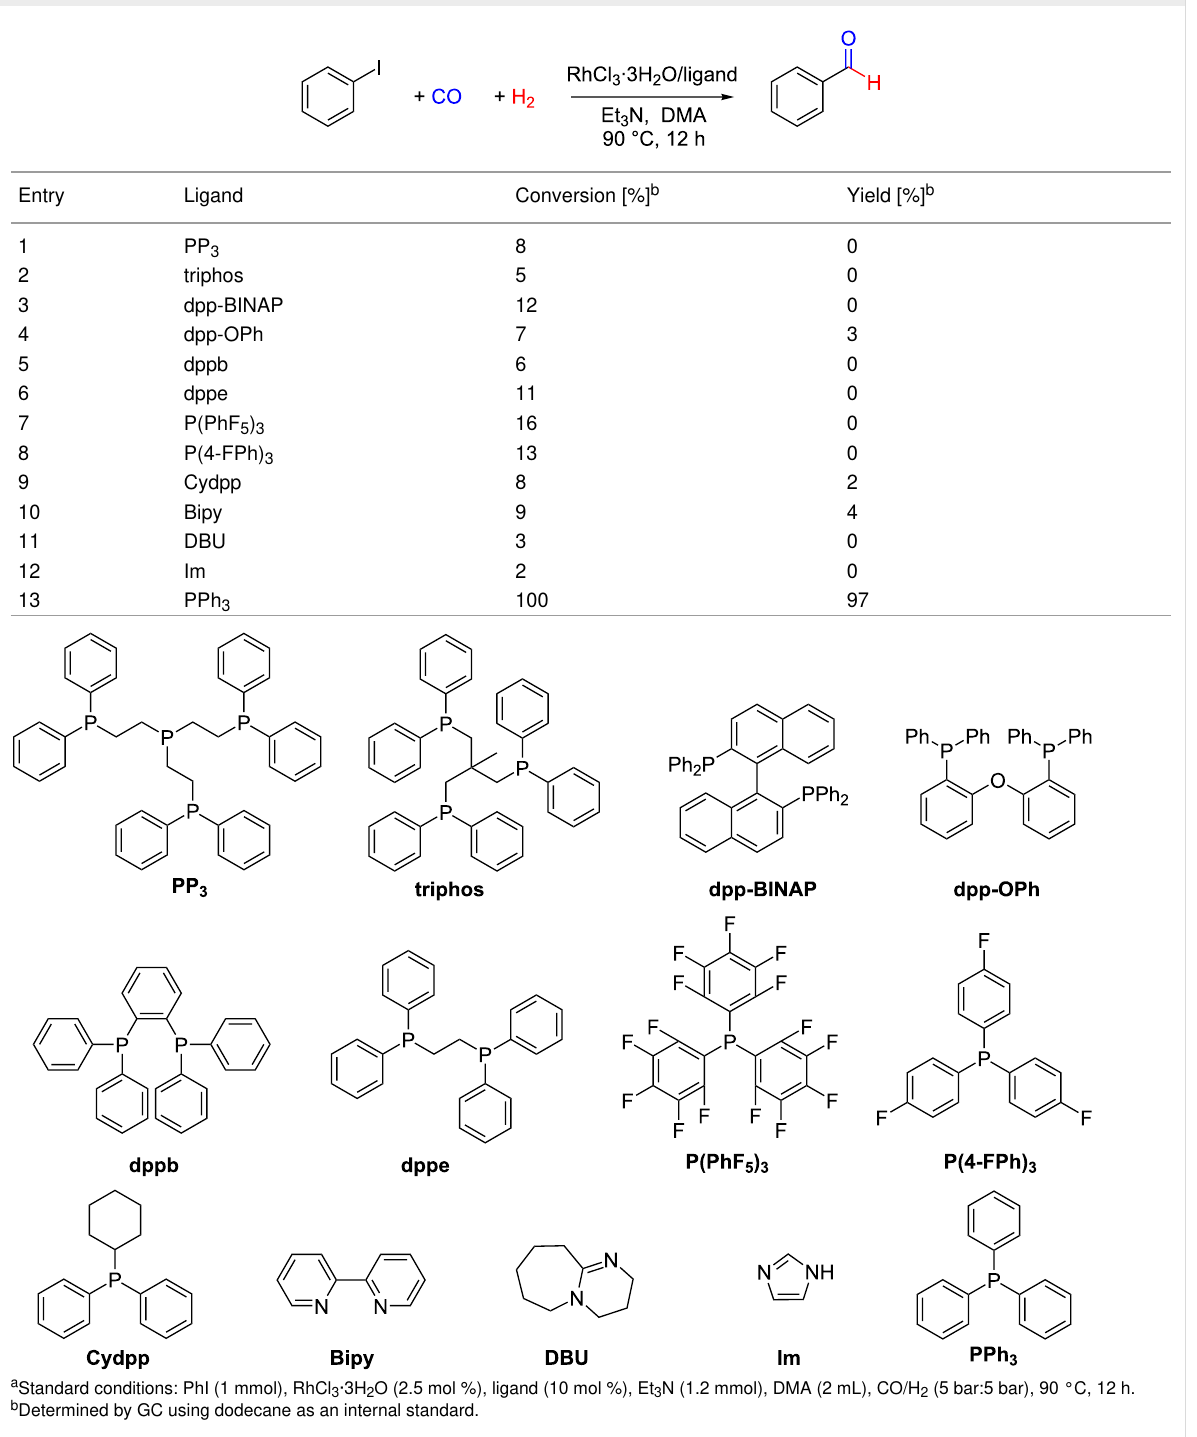
Table 2: Rhodium-catalyzed reductive carbonylation of iodobenzene with CO and H 2 to afford benzaldehyde: effects of the ligands a